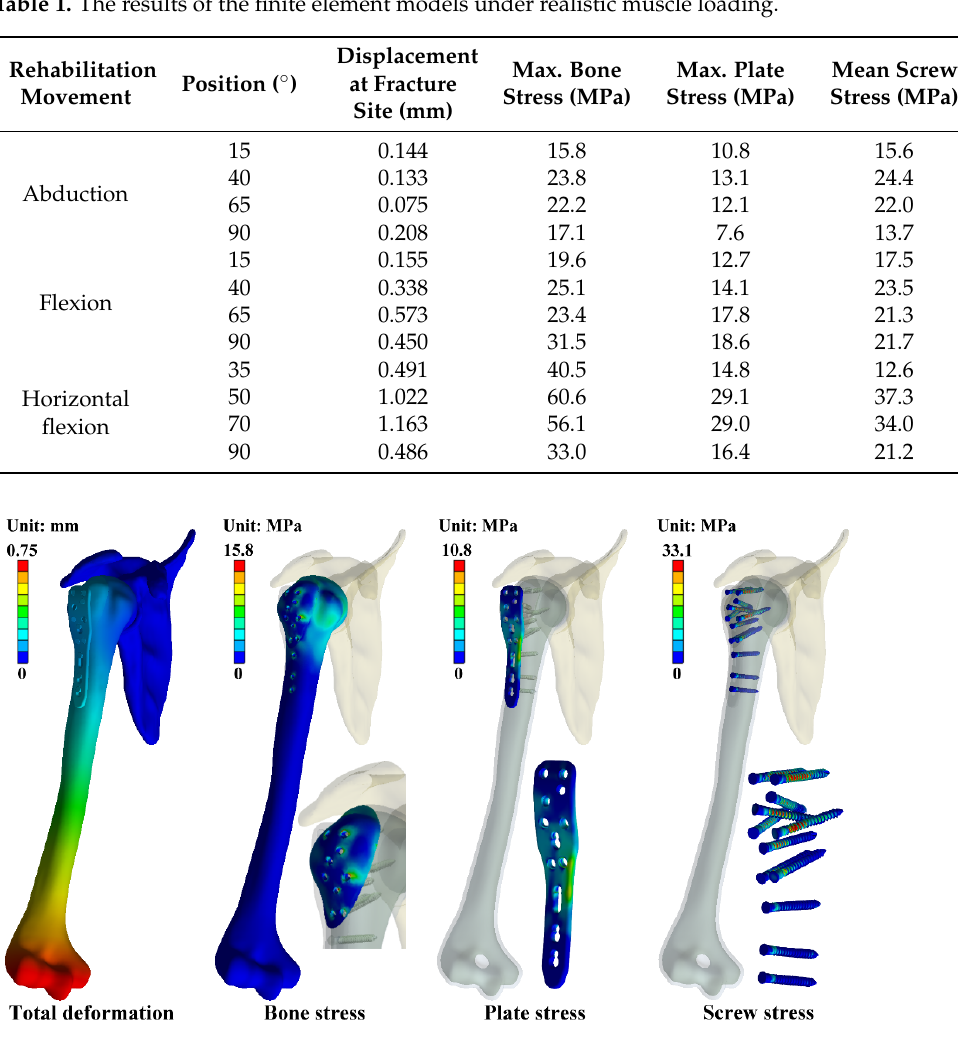
Figure 7. The deformation and stress distributions of the finite element models under the shoulder joint activity position of 15° for abduction.